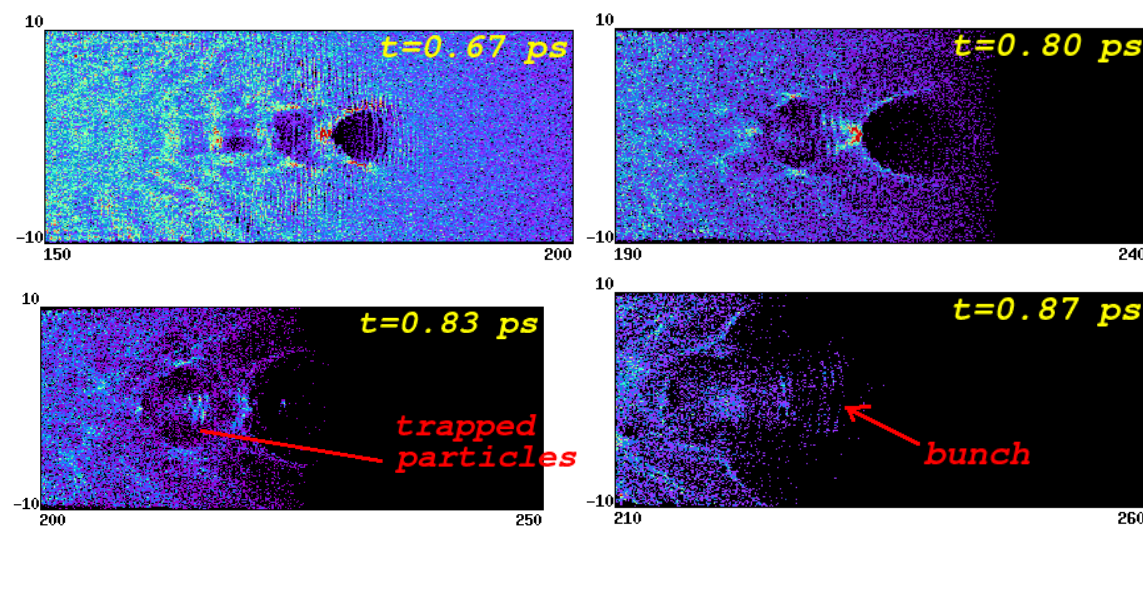
Figure 5. Electron density cut at different times, as obtained from PIC simulation, showing the growth of the wake-field structure. The observation window of the code moves at the speed of light following the laser propagation. Electron density increases from blue to